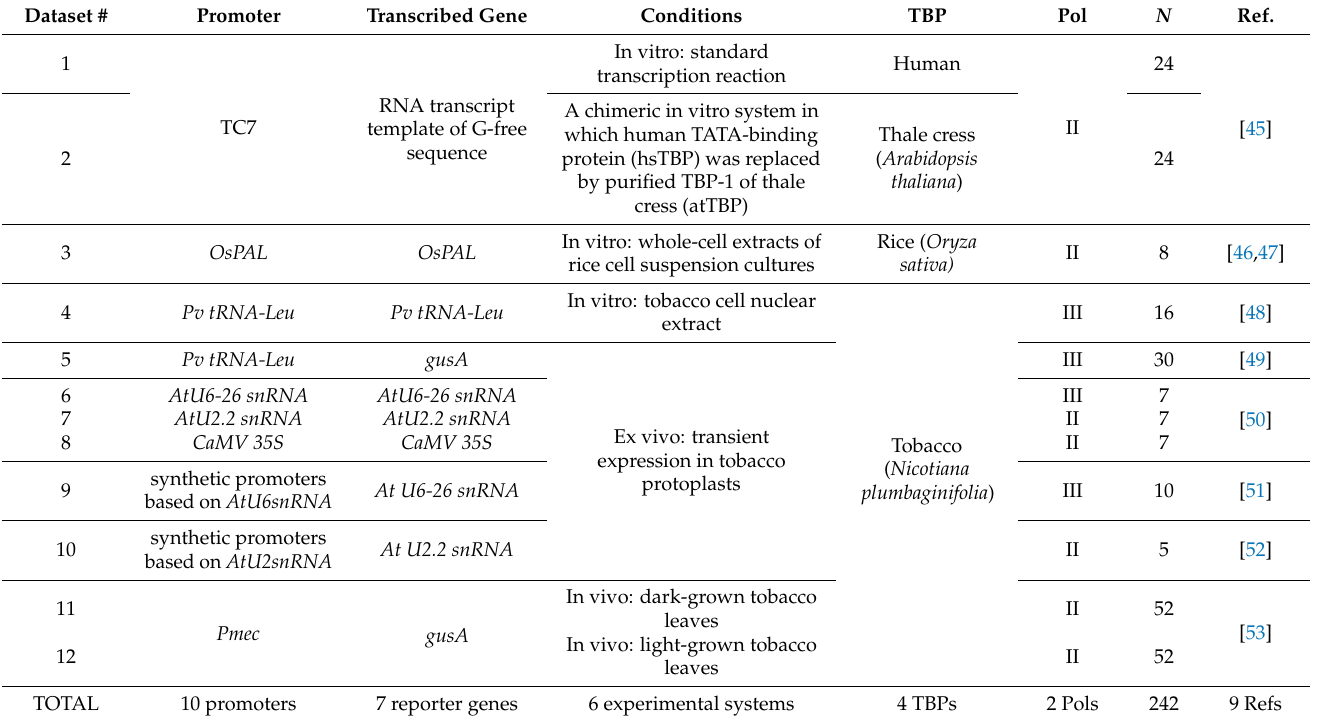
Table 1. The experimental data—on the effects of mutations in the plant promoters on gene expression—that we could find in the PubMed database